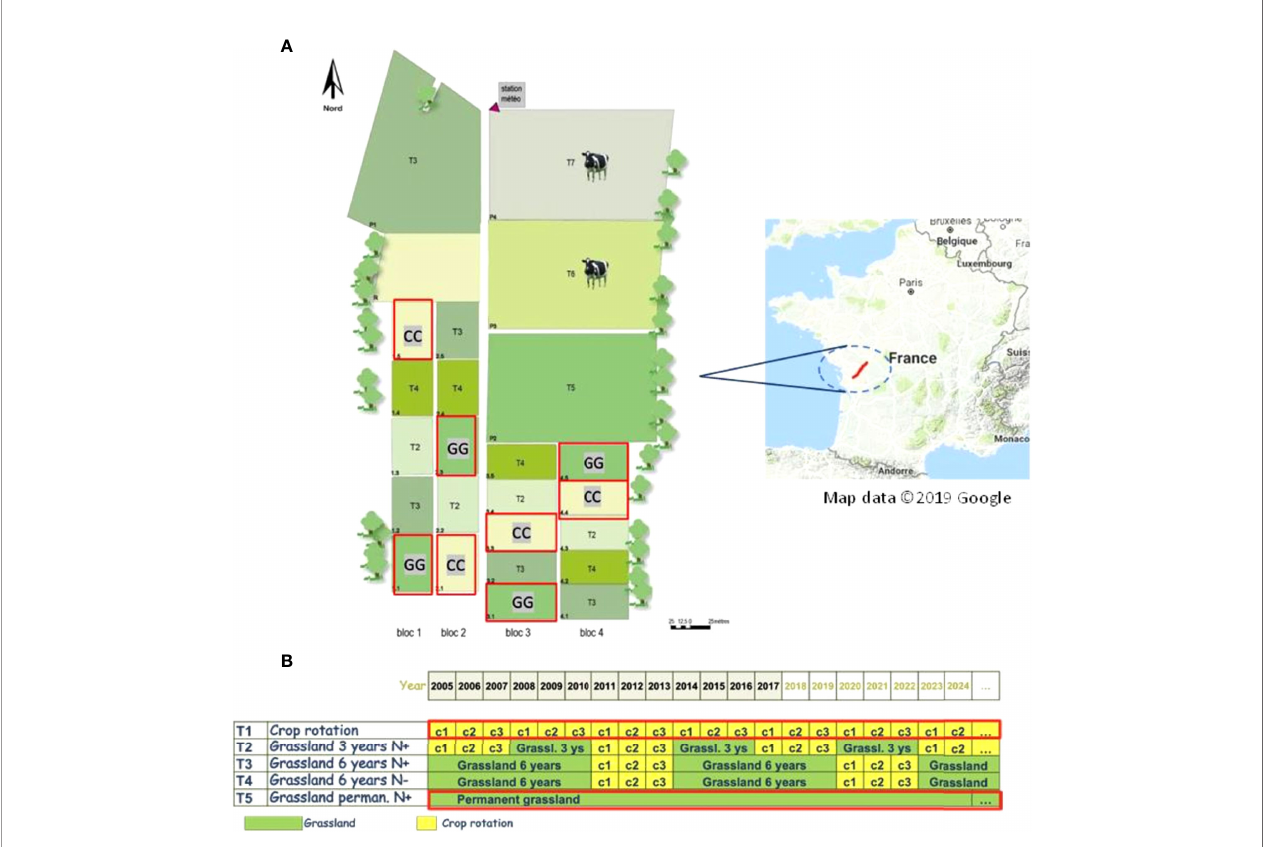
FIGURE 1 | Lusignan National Long-Term Observatory at Nouvelle-Aquitaine Region, France (A) target treatments from 2005-2017 used in the current study (B) are shown in the red